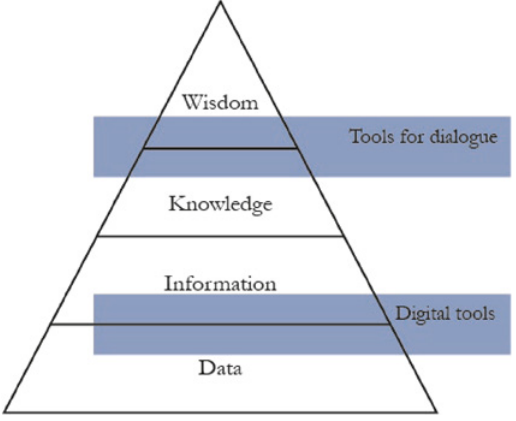
The digital tools and the dialogue tools placed into the knowledge